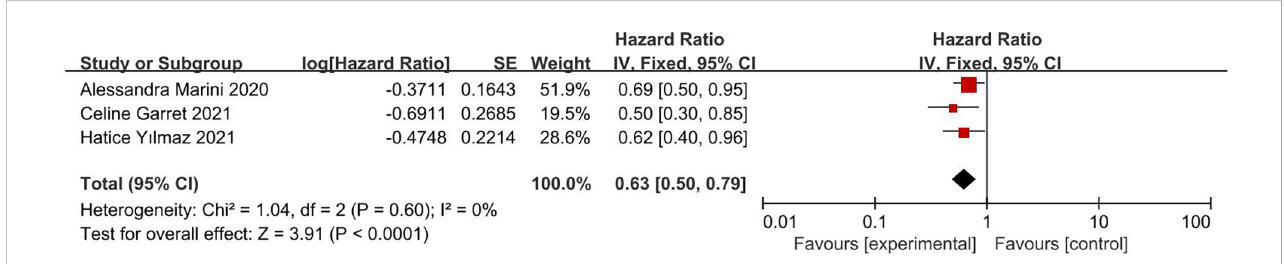
FIGURE 4 Forest plot of correlation between PNI score and PFS in univariate analysis data.